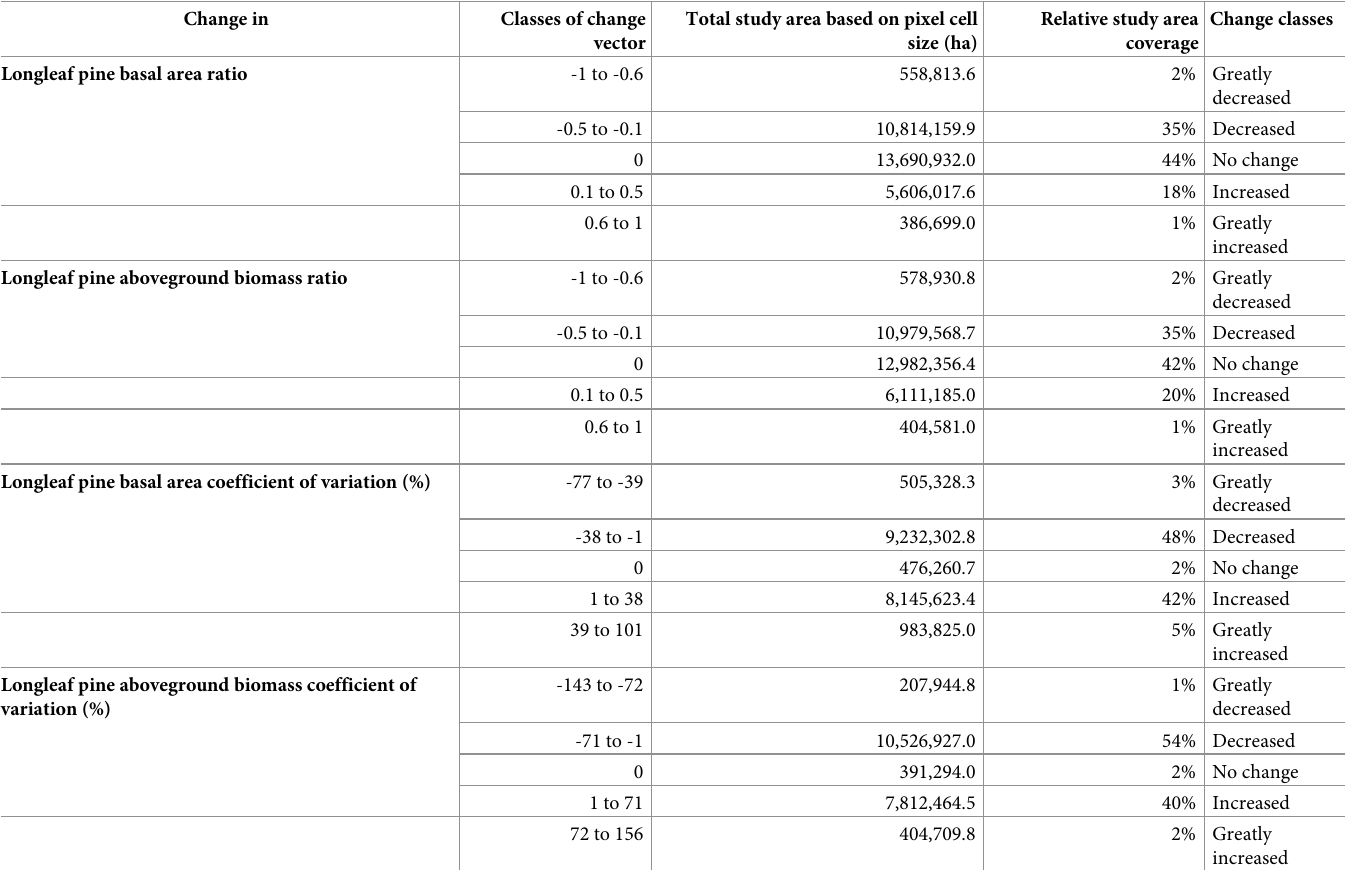
Table 5. Change classes for basal area ratio, aboveground biomass ratio, basal area coefficient of variation and aboveground biomass coefficient of variation of longleaf pine across the plots between 2004 and 2011, where 2004 and 2011 are the centroid-year of first (1997–2010) and last (2003–2018) inventory intervals, respectively (N =